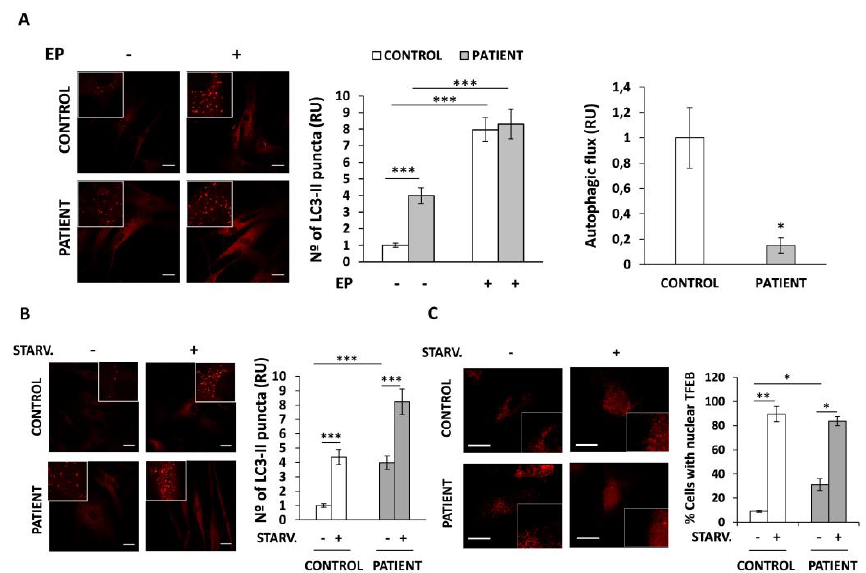
Figure 3. Autophagy analysis in HACE1 patient fibroblasts. Autophagy was measured by immunofluorescence measuring the average number of LC3 puncta per cell and the percentage of cells with TFEB translocated to the nucleus. ( A ) LC3 puncta was significantly increased in HACE1 fibroblasts compared to control cells. The autophagic flux, calculated as the relative increase in LC3puncta after 24 h of EP treatment compared to the basal levels observed in untreated cells, was importantly diminished in HACE1 fibroblasts. ( B ) Upon serum starvation treatment the number of LC3 puncta was increased in both, patient and control fibroblasts, indicating a normal activation of the autophagy. ( C ) The analysis of TFEB by immunofluorescence showed a massive translocation of TFEB to the nucleus after serum starvation treatment in both, control and HACE1 fibroblasts. In all cases a minimum of 70 cells were analysed. Scale bar, 30 µ m. Relative units (RU); E64D-Pepstatine A (EP); * p < 0.05; ** p < 0.01, *** p < 0.001.